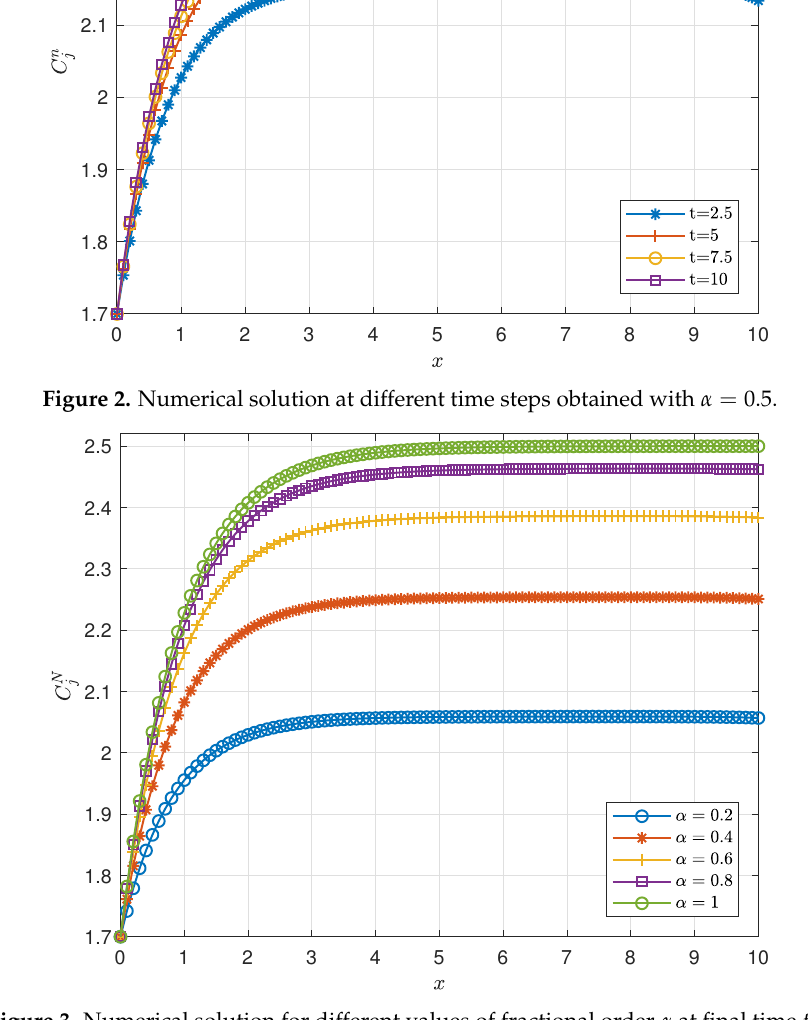
Figure 3. Numerical solution for different values of fractional order α at final time t N